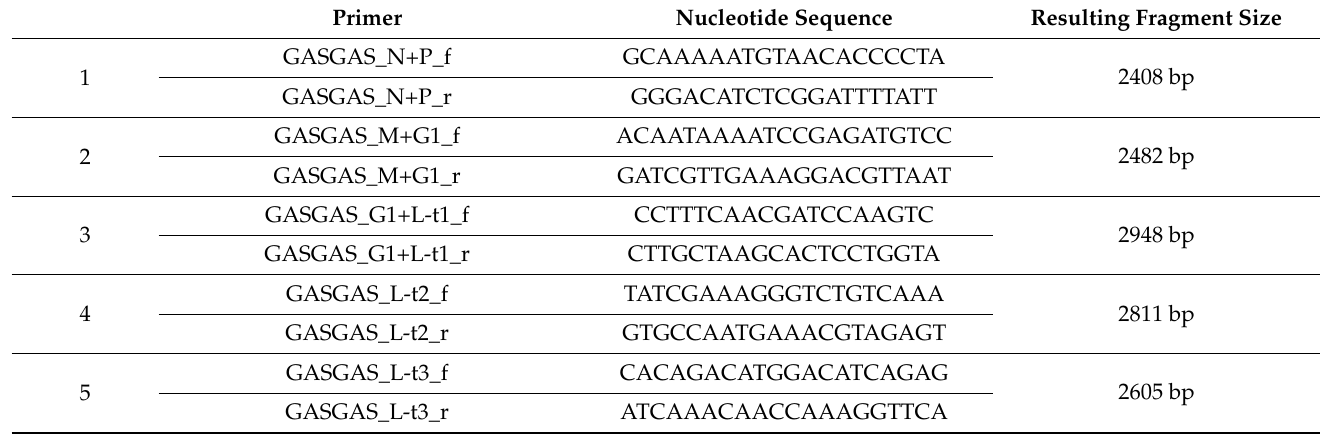
Table 1. Primer sequences for gene amplification.